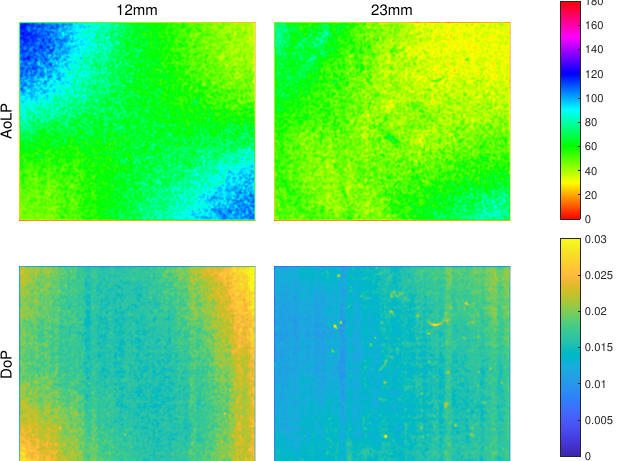
Figure 20. AoLP ( top ) and DoP ( bottom ) images for pure resin surfaces under the dome using a 12 mm lens ( left ) and 23 mm lens ( right ). The images have been smoothed by using a Gaussian filter of 5 pixel standard deviation since the original images had very high SNR and are, thus, difficult to interpret.